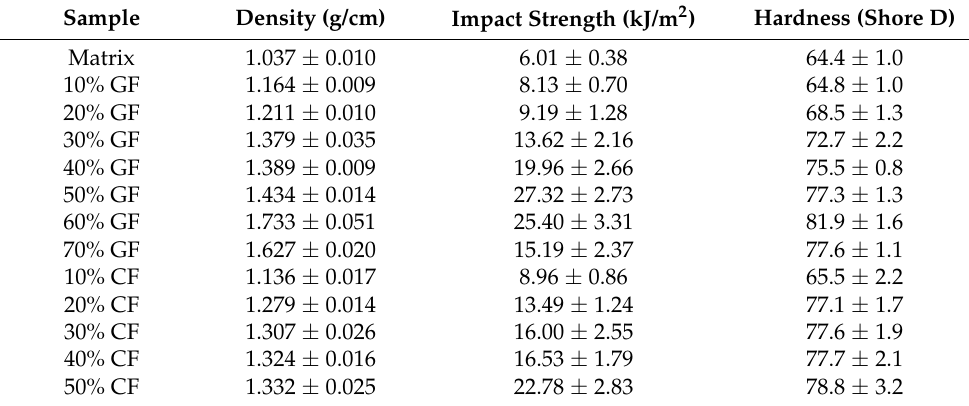
Table 2. Density, impact strength, and hardness of the obtained